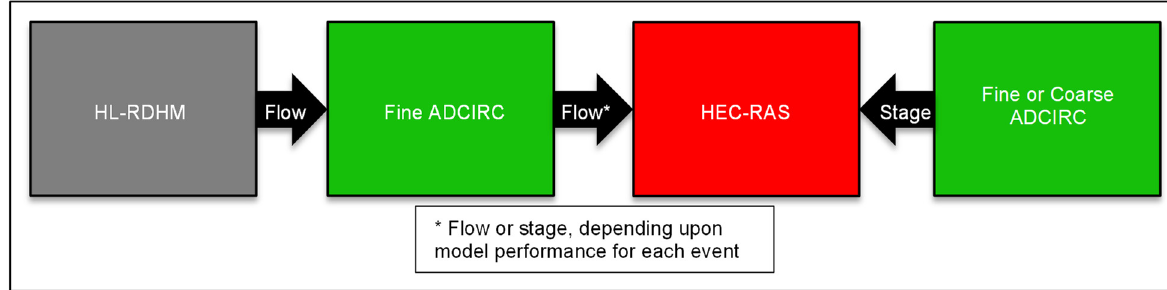
Figure 4. Coupling scheme 3: HEC-RAS sequential forcing.